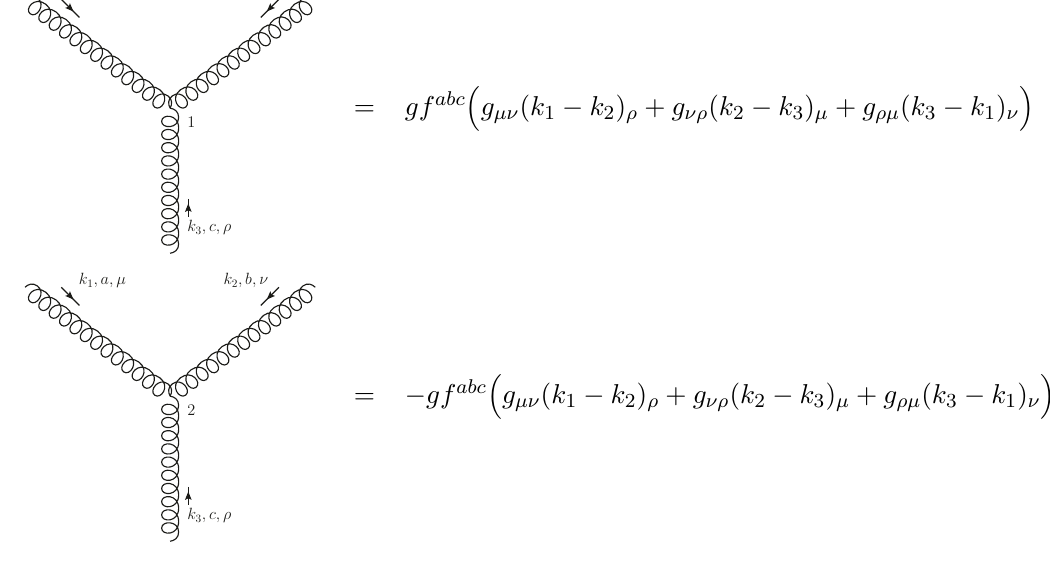
Figure 3. Feynman rules associated to the 3-gauge boson vertex, for both types of fields on the branches of the Schwinger-Keldysh contour along the real-time